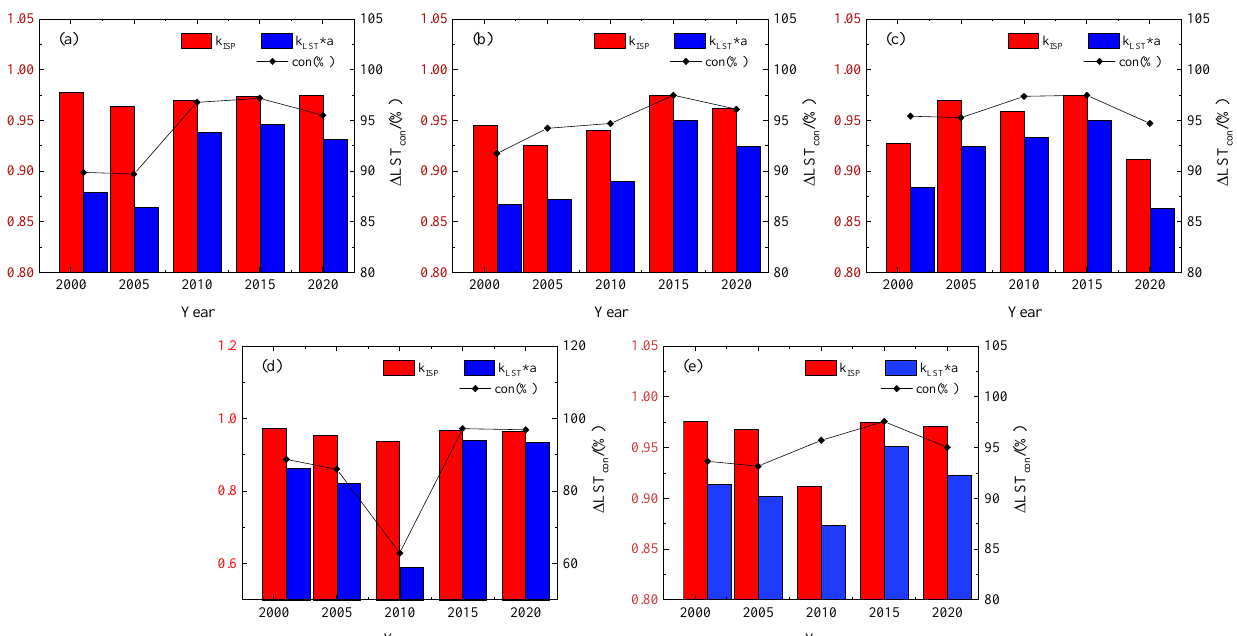
Figure 6. The land-surface-warming-induced contribution to the effects of urbanization on NPP during 2001–2020. Note: ( a ) spring; ( b ) summer; ( c ) autumn; ( d ) winter; ( e ) year. k ISP represents the total indirect effect of urbanization; k LST ∗ a represents the indirect effects of warming on